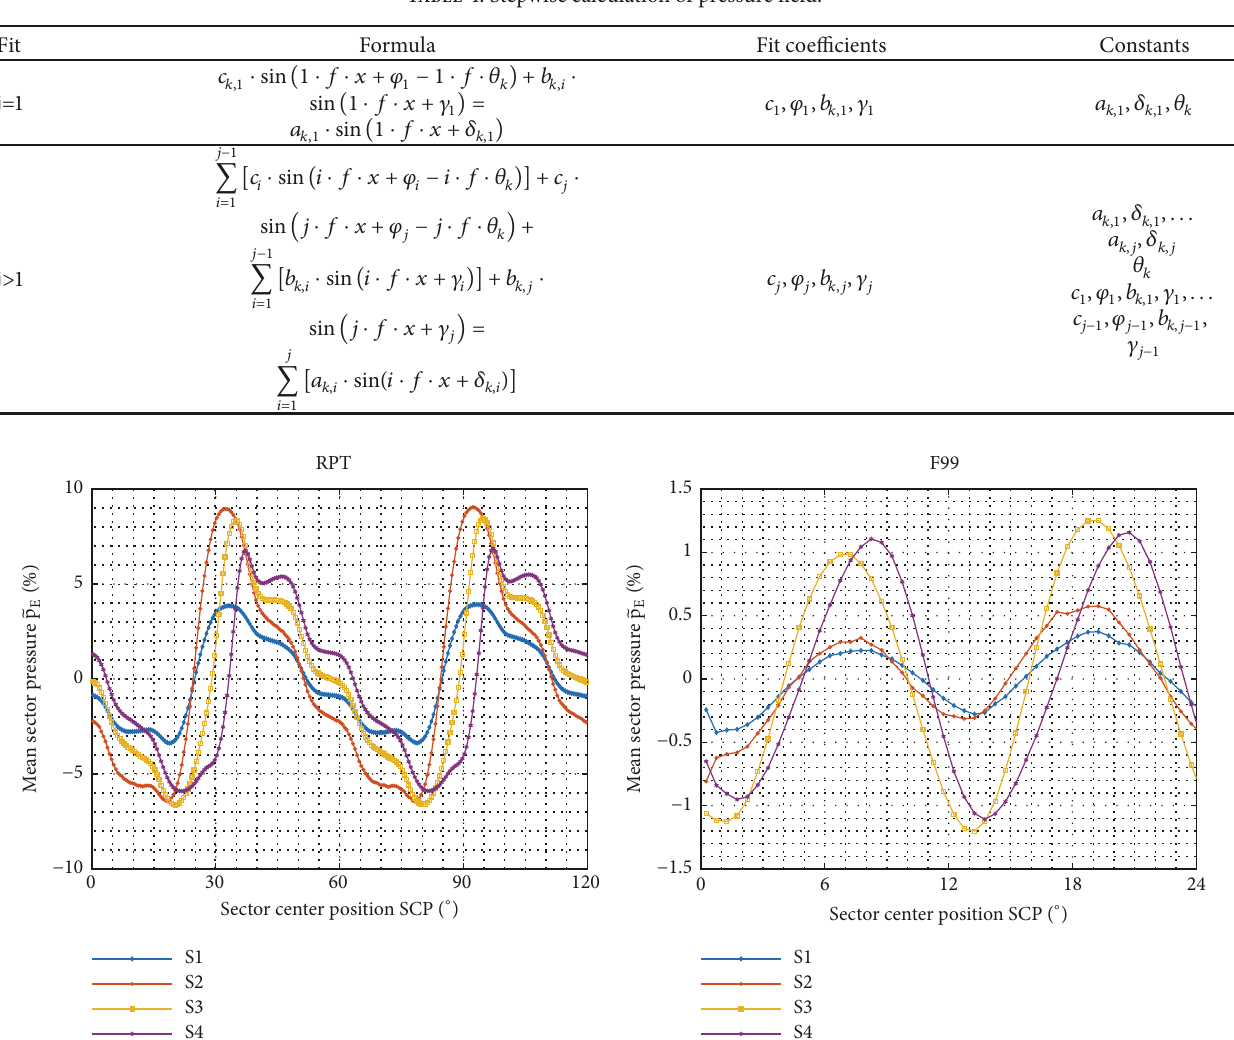
Table 4: Stepwise calculation of pressure field.